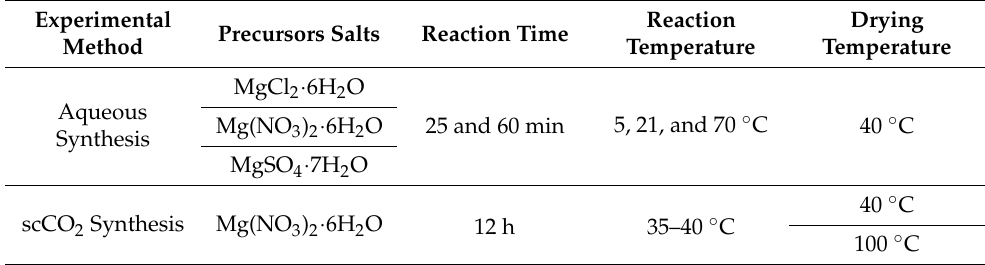
Table 1. Design of